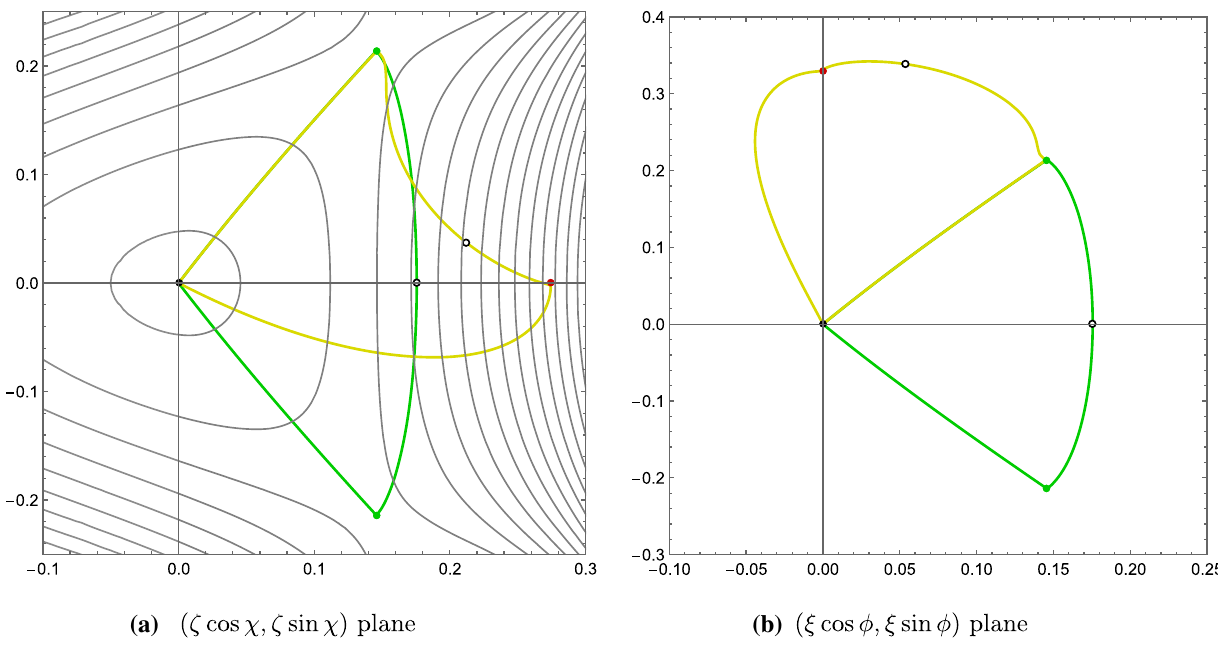
Fig. 3 Janus solutions describing G 2 / U ( 3 ) and G 2 / G 2 interfaces are respectively shown by yellow and green lines on the contour plot of the